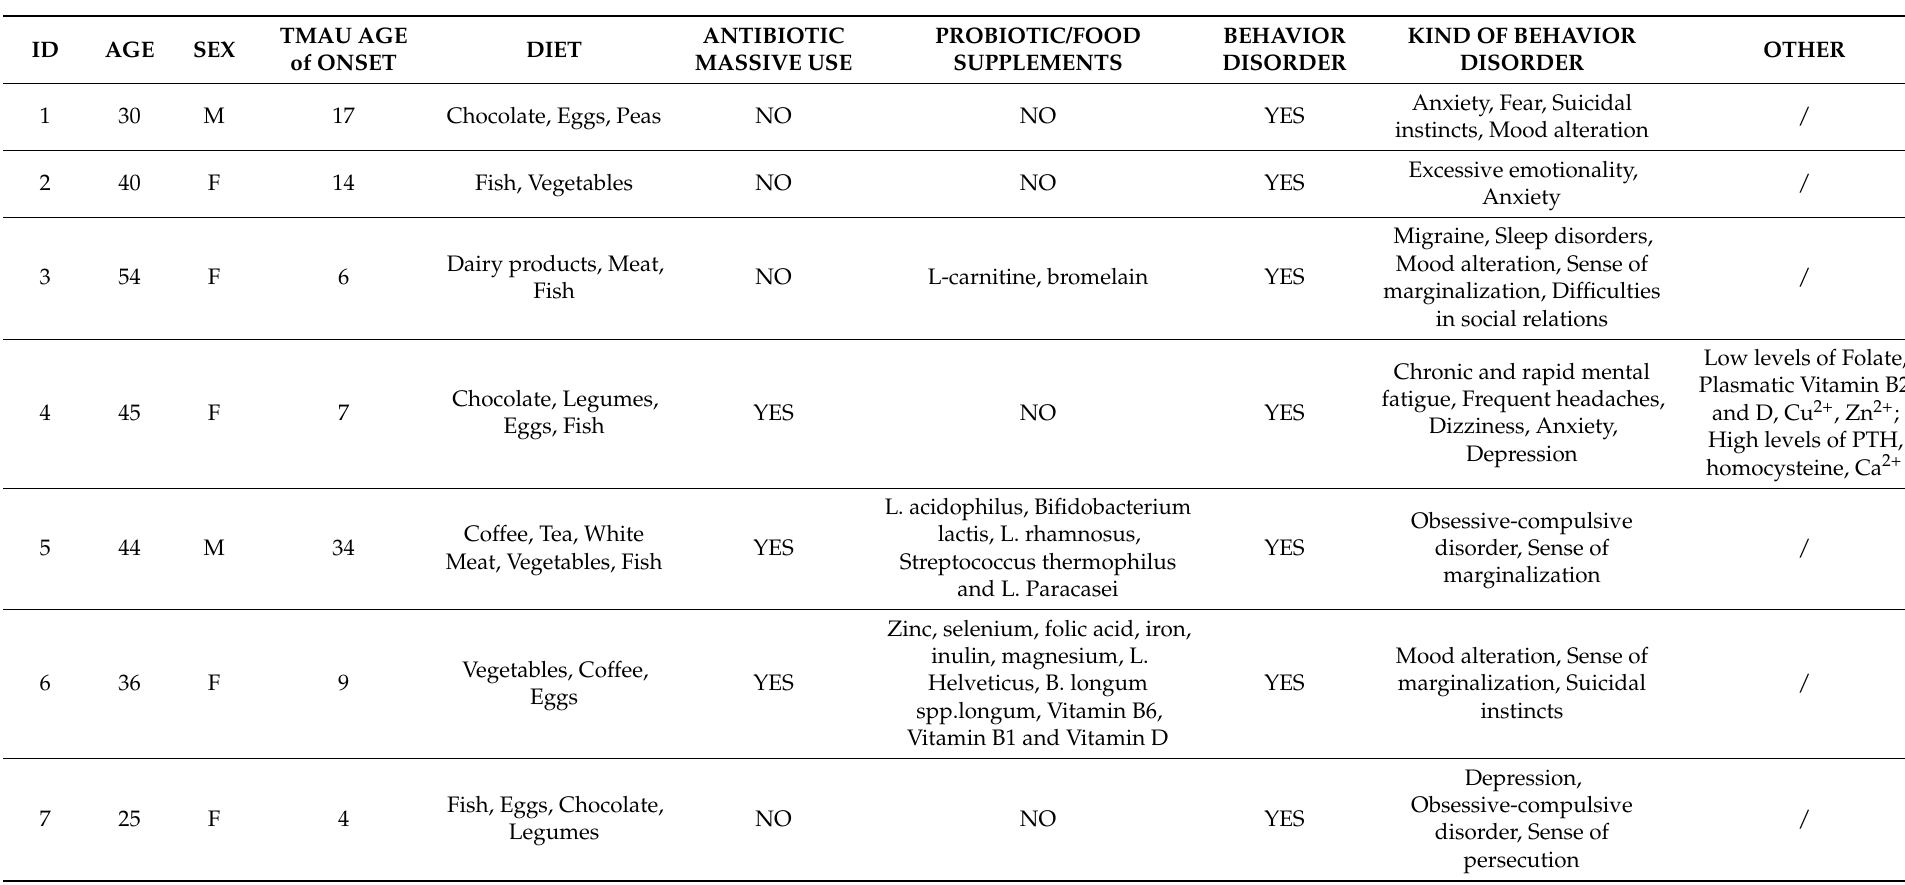
Table 1. Subject metabolic and behavioral features. TMAU patients with psychiatric symptomatology (1–7) and TMAU control patients without mental disturbs (1c–5c) were selected for our retrospective comparison, mainly in relationship with relevant differences of behavioral